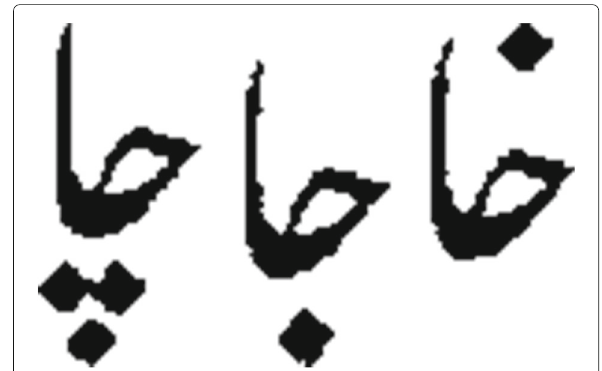
a recognition rate of 92.7%. Malik and Faheim [15] pre- sented a line and character segmentation scheme that mainly relies on projection profiles. The under- and over- segmentations are handled through a set of heuristics.